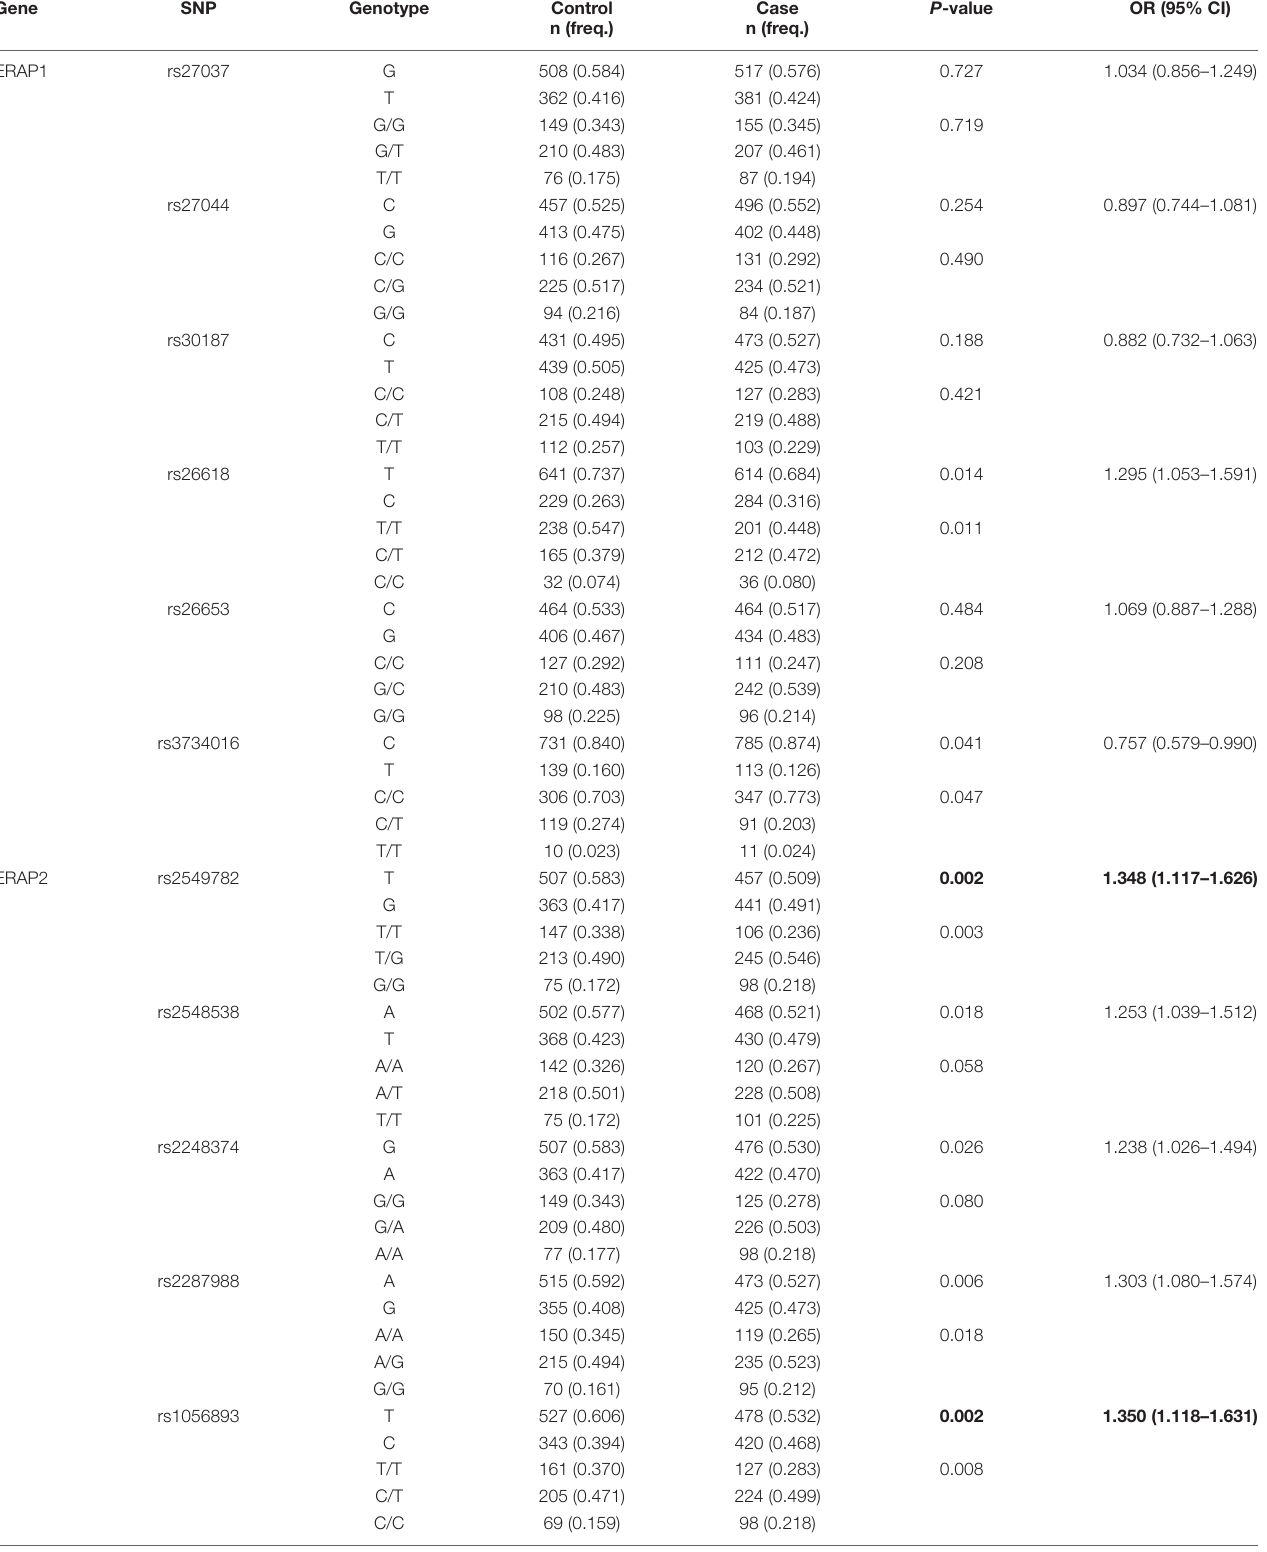
TABLE 2 | The allelic and genotypic distribution of ERAP1 and ERAP2 genes in the TB and the control groups. Gene SNP Genotype Control Case P -value OR (95% CI) n (freq.) n